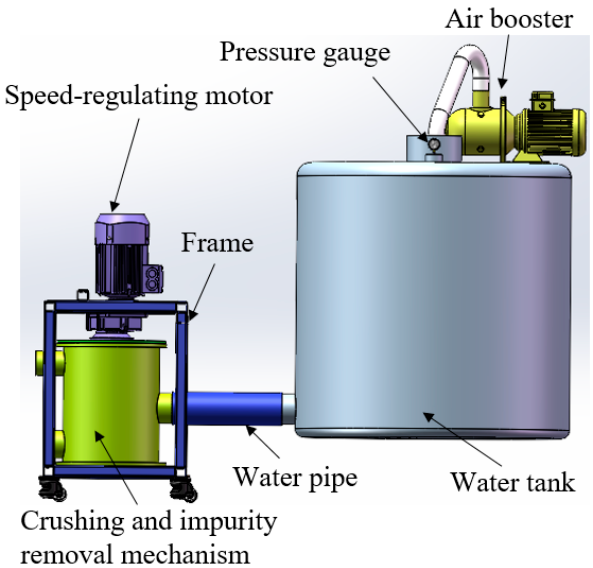
Figure 6. Schematic of the test platform.